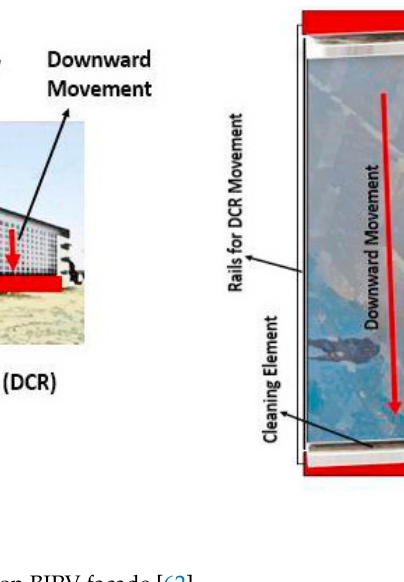
Figure 21. A new CMS uses a radiometer sensor embedded in a UAV to detect dust on PV panels [45]. It was found that most of the module cleaning studies were performed on the horizon- tal and tilted PV panels installed either on the building rooftop or on the open ground. For high-rise buildings, the cleaning of panels can be implemented as discussed by [62], and the cleaning robots can be installed on the top or bottom of the envelope edge. The robots will be provided with sensors to sense the level of dust and moisture on the surface. The robot will move in an upward/downward direction on the rails provided on the side of the envelopes (Figure 22).